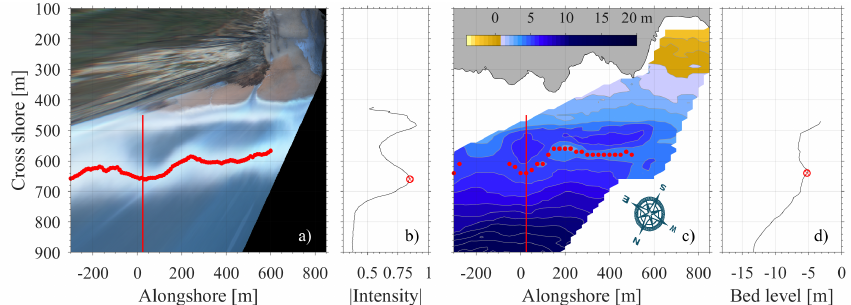
Figure 3. Typical sub-tidal bar detection with Timex pixel intensities ( a , b ) and bathymetry estimate ( c , d ). Panel ( a ) shows an arbitrary projected Timex image with 1 × 1 m spacing and the vertical red line indicates an exemplary cross-shore transect on which the bar position is determined (similarly in c )). Panel ( b ) represents normalized pixel intensity over the red line shown in the projected Timex image. The bar detection using a video-derived bathymetry is shown in ( c ) with the corresponding profile in ( d